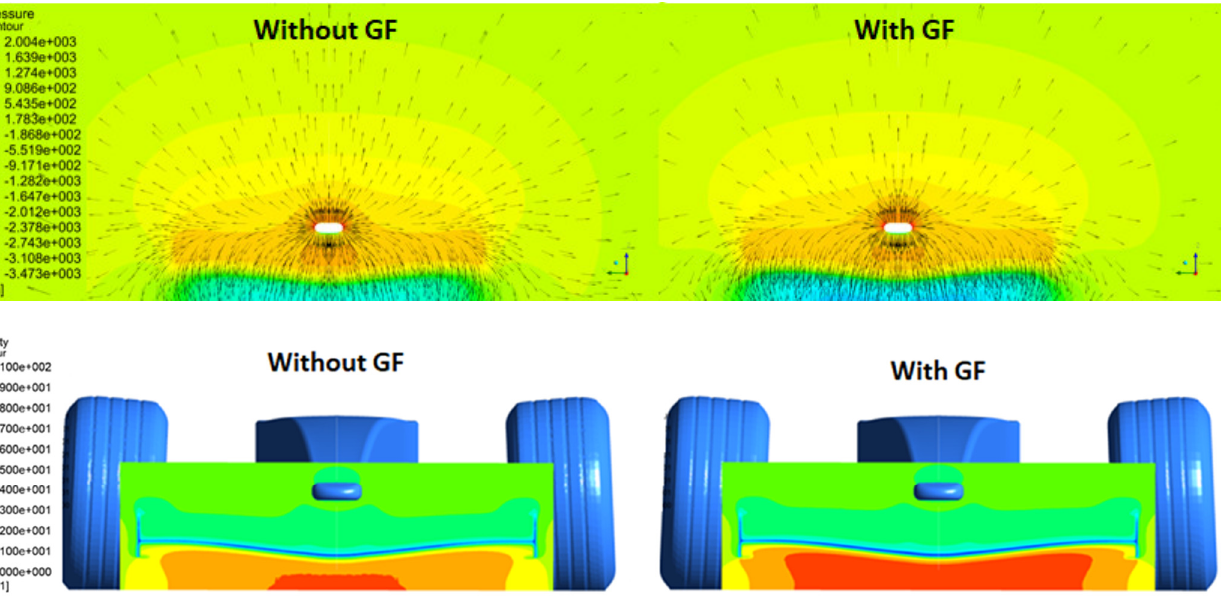
Figure 8. Comparison on the x 1 plane of distributions between the case with ( right ) and without GF ( left ): ( above ) pressure contours with velocity vectors, ( below ) velocity contours.